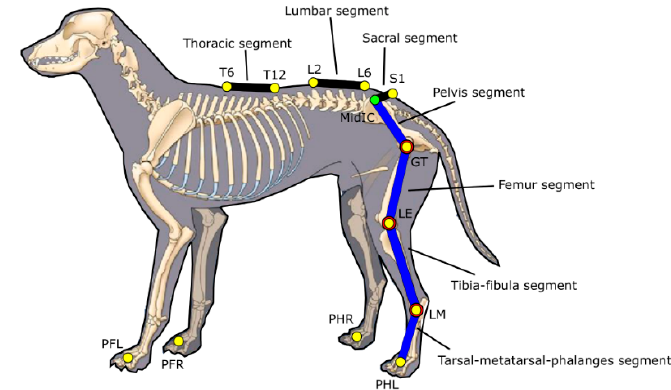
Figure 1. Marker-set of 17 retro-reflective spherical markers attached to selected ALs; the multi- segmental model included 10-line segments including three segments for modeling the back (sacral segment, lumbar and thoracic segments). Tarsus, stifle and hip joints are modeled as spherical hinges. Marker locations on the spine were chosen so that data on the physiological spine movements transition area [12] and in L7-S1 segments, could be collected [22].